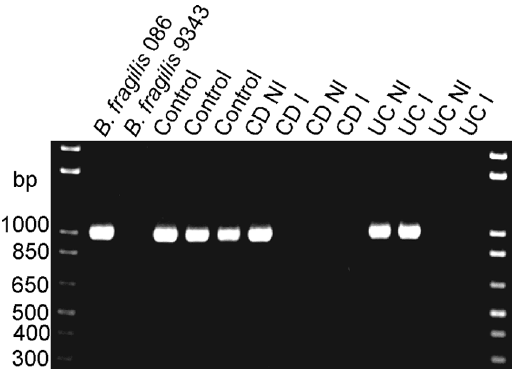
Figure 4. PCR analysis of bft from B.fragilis isolates. Lane one contains a bft containing strain (086 care of C. Sears, MD). Lane two contains a B. fragilis strain without bft (9343). Lane three contains an isolate from the terminal ileum (TI) of subject 34. Lanes four and five contain isolates from TI and ascending colon biopsies from control subject 43. Lane 6 contains an isolate from the non-inflamed terminal ileum of a subject 71 with CD. Lane 7 contains an isolate from an inflamed TI biopsy of subject 64 with CD. Lanes 8 and 9 contains isolates from non-inflamed rectal and inflamed ascending colon biopsies of a subject 74 with CD. Lanes 10 and 11 are isolates from non-inflamed TI and inflamed descending colon biopsies of a subject 39 with UC. Lanes 12 and 13 are isolates from an non-inflamed cecal biopsy and inflamed rectal biopsy from subject 62 with UC.